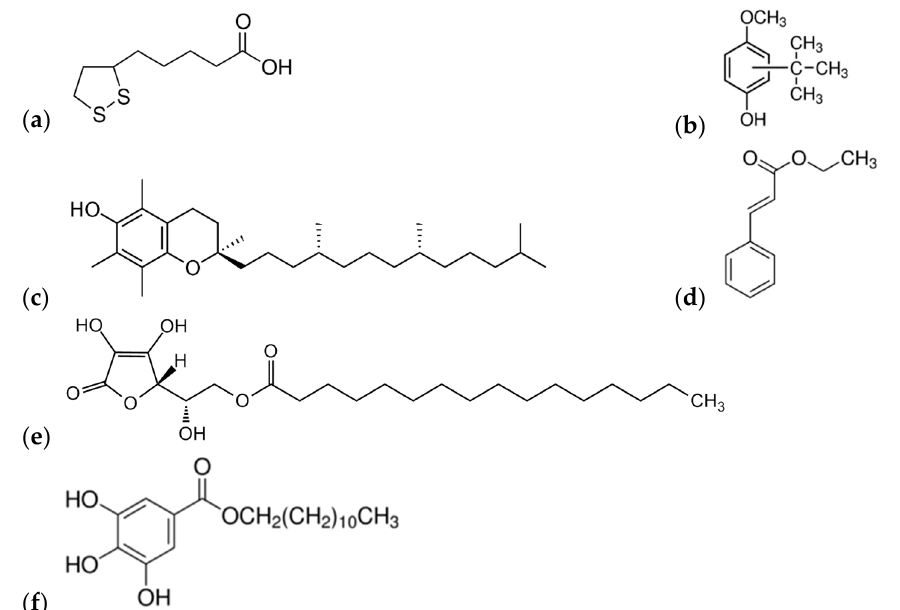
Figure 1. Structural formulas of the used antioxidants: ( a ) Thioctic acid ( α -Lipoic acid; natural product; hydrogen-transferring co-factor); ( b ) Butylated hydroxyanisole (synthetic antioxidant); ( c ) α -Tocopherol (Vitamin E; E307 in food); ( d ) Ethyl cinnamate (Ethyl (2Z)-3-phenylprop-2-enoate); ( e ) L-Ascorbic acid 6-palmitate (oil soluble vitamin C); and ( f ) Dodecyl gallate (food additive E312; antioxidant and preservative).